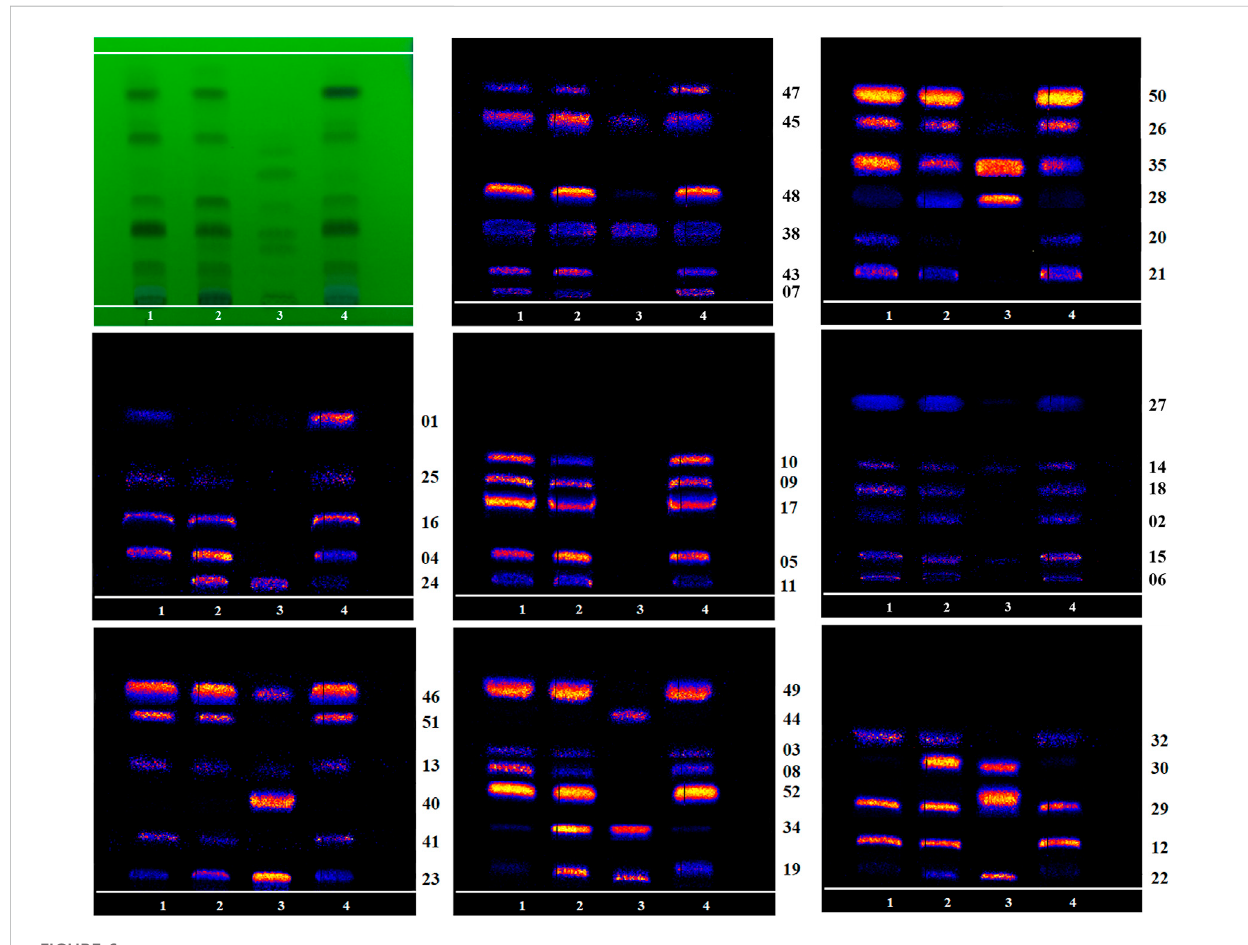
FIGURE 6 Mass Spectrometry Imaging comparison of 46 other identi fi able alkaloid components on HPTLC (1: R-TBC, 2: F-TBC, 3: D-TBC, 4: H-TBC).